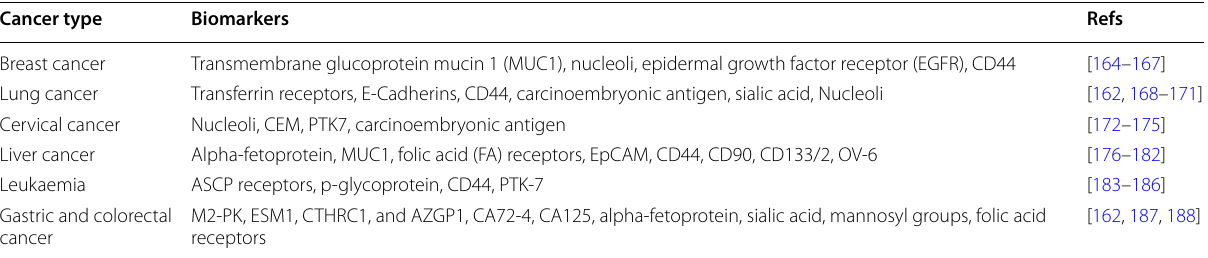
Table 2 Different types of cancers and their respective biomarkers overexpressed on their surfaces during metastatic transformations Cancer